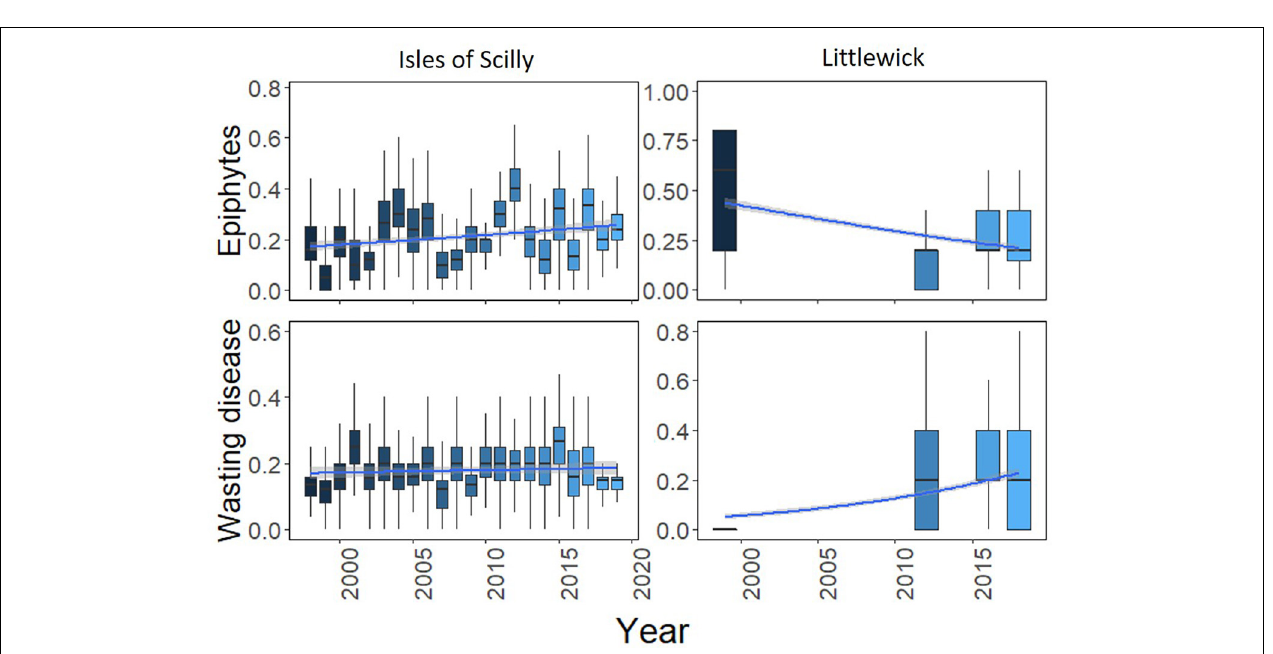
FIGURE 5 | Boxplots showing change in average leaf length over time for Littlewick, Porthdinllaen, and average maximum leaf length for Isles of Scilly. The box-whisker represents the median (line) and interquartile range (box) with additional 1.5 × interquartile range shown as whisker and a temporal trendline in blue (GLM smooth with Gamma family), grey area shows 95% confidence. Outliers not shown for clarity (data provided by NRW, Project Seagrass, and Natural England respectively, with data from this study included for Littlewick).